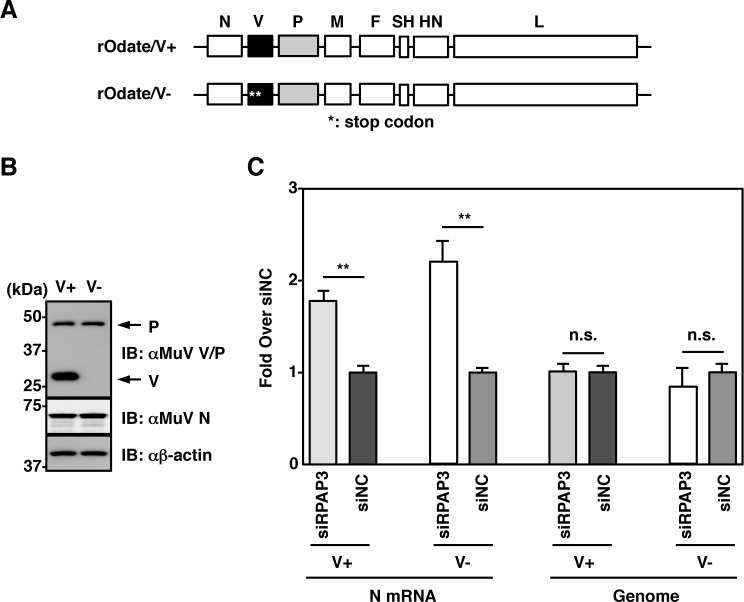
Enhanced viral transcription in RPAP3-knockdown cells is independent of V protein function.(A) Schematic of the rOdate/V+ and rOdate/V- genes. (B) Vero cells were infected with rOdate/V+ or rOdate/V- at an MOI of 3.0. Cell lysates were collected at 24 hpi and subjected to immunoblotting with the indicated antibodies. (C) At 48 h post-transfection with either siRPAP3 or siNC, A549 cells were infected with rOdate/V+ or rOdate/V- at an MOI of 3.0 and incubated for 24 h. Relative levels of N mRNA and genomic RNA (based on levels in cells transfected with siNC) were determined by qPCR. Error bars indicate the standard deviations of triplicate wells. The significance of differences between means was determined using the Student’s t-test. **p<0.01. n.s. = not significant.